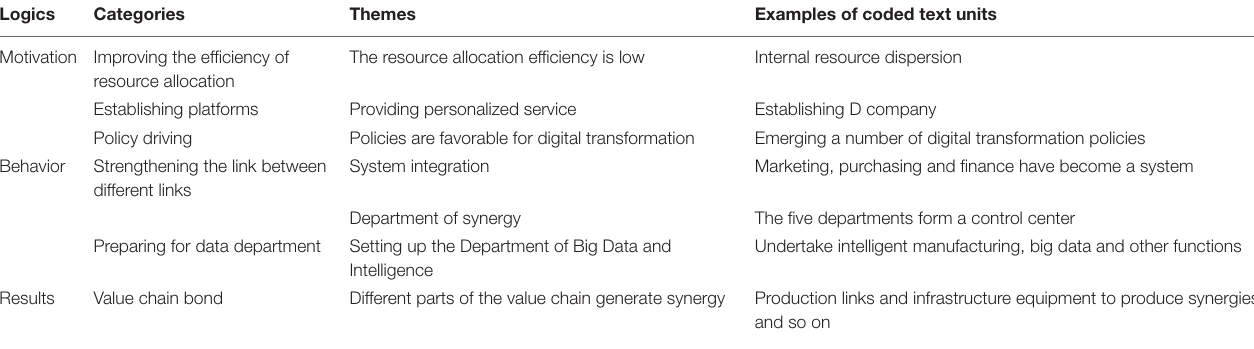
TABLE 4 | Phase 3 value chain